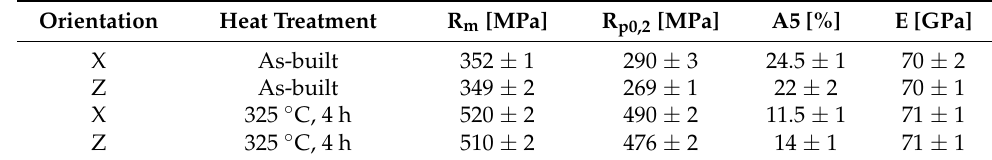
Table 5. Quasistatic properties of turned tensile specimens with geometry B6 × 30. Orientation Heat